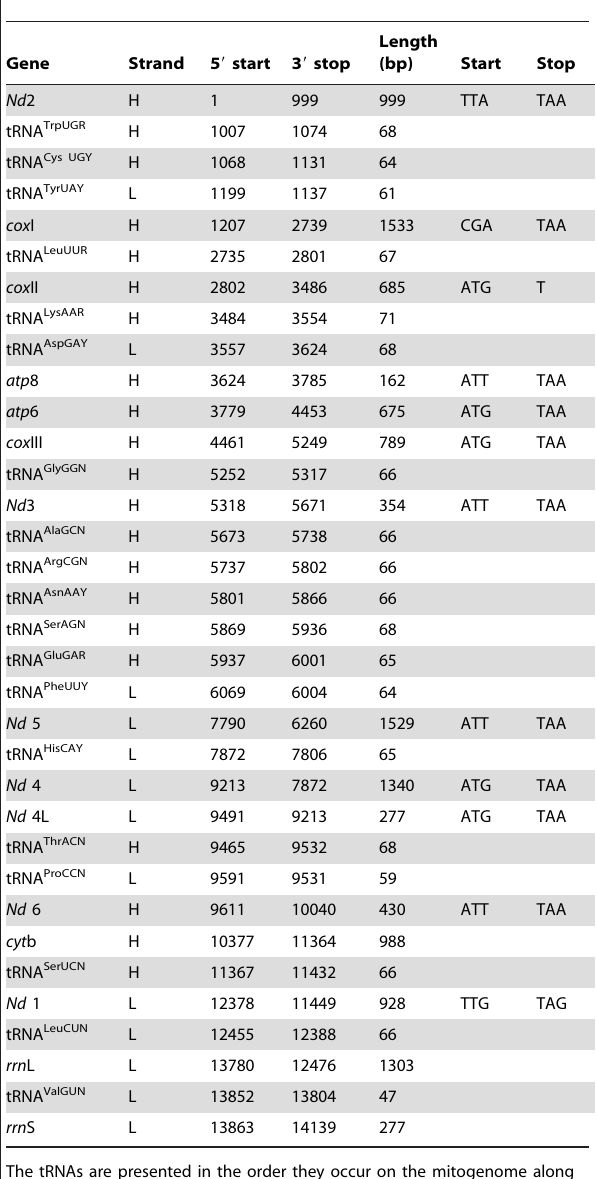
Table 2. Summary of Maruca vitrata predicted tRNAs.